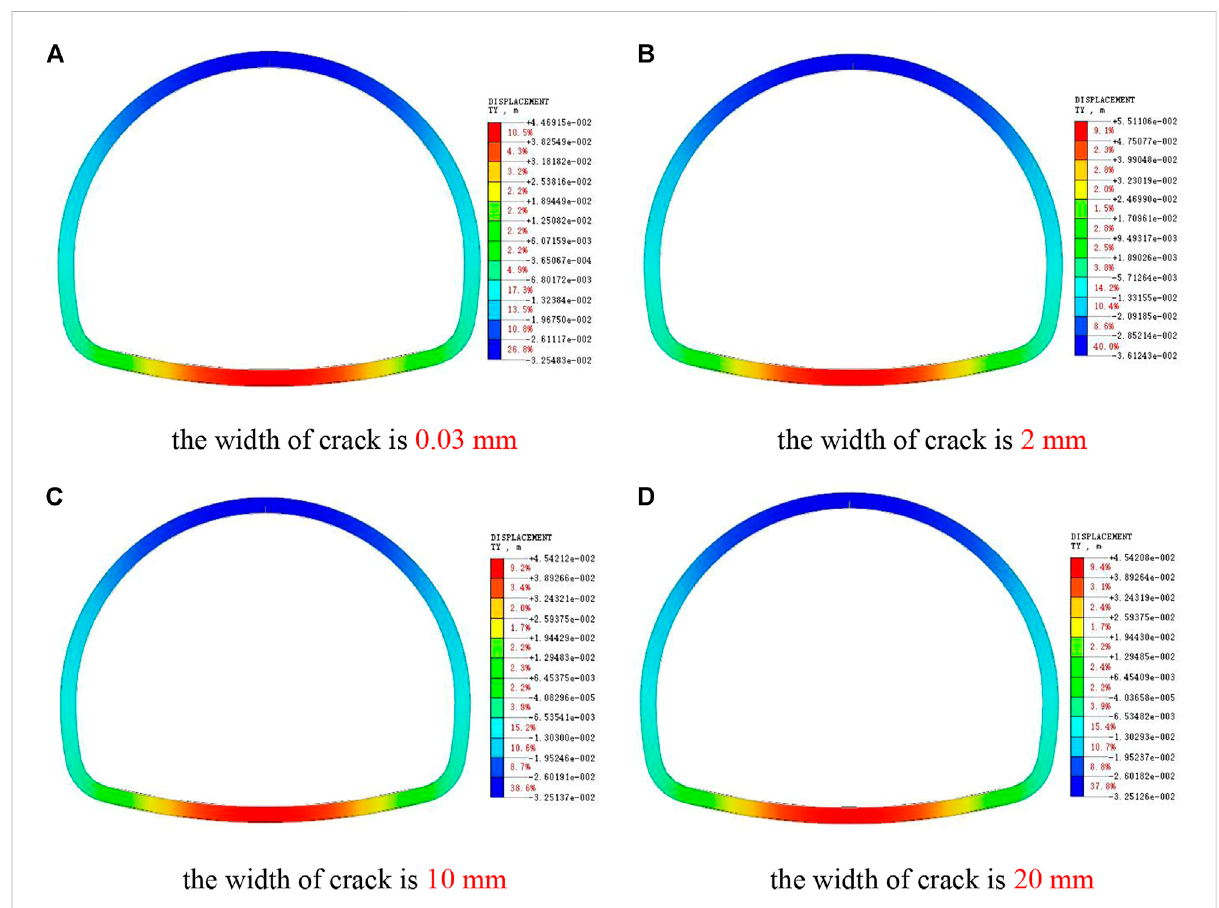
FIGURE 10 Cloud picture of Y-direction displacement of arch shoulder crack lining. (A) The width of crack is 0.03 mm. (B) The width of crack is 2 mm. (C) The width of crack is 10 mm. (D) The width of crack is 20